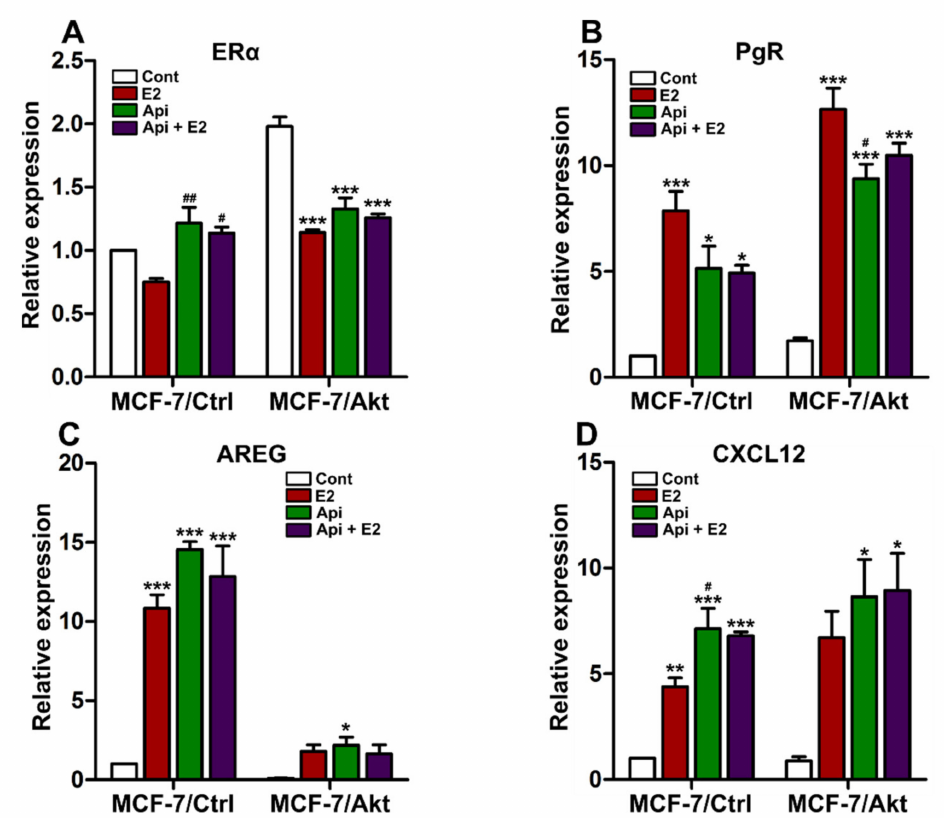
Figure 3. Effect of apigenin on ER target genes. MCF-7/Ctrl cells and MCF-7/Akt cells were treated with 0.1% ( v / v ) DMSO and 0.1% ( v / v ) ethanol as the control (Cont), 1 nM estradiol (E2), or 10 µ M apigenin (Api) alone or in combination with E2 for 24 h. The gene expression of estrogen receptor 1 (ER α ) ( A ), progesterone receptor (PgR) ( B ), amphiregulin (AREG) ( C ) and chemokine (C-X-C motif) ligand 12 (CXCL12) ( D ) was assessed by real-time PCR and normalized to the expression of the housekeeping genes GAPDH and TBP. The experiment was conducted three times in triplicate. The results are expressed as the fold change in gene expression compared with that in the control of the MCF-7/Ctrl cells and are presented as the mean ± SEM. Statistical analyses were performed with one-way ANOVA followed by Tukey’s post hoc test. * p -value < 0.05, ** p -value < 0.01, *** p -value < 0.001 indicate significant differences from the control group in the same clone. # p -value < 0.05, ## p -value < 0.01 indicate significant differences from the E2 group in the same